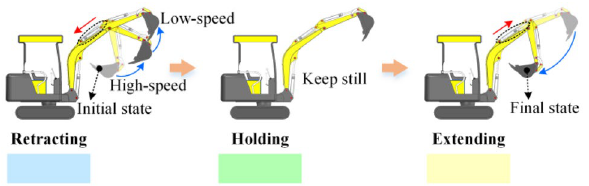
Figure 9 Schematic diagram of the arm movement